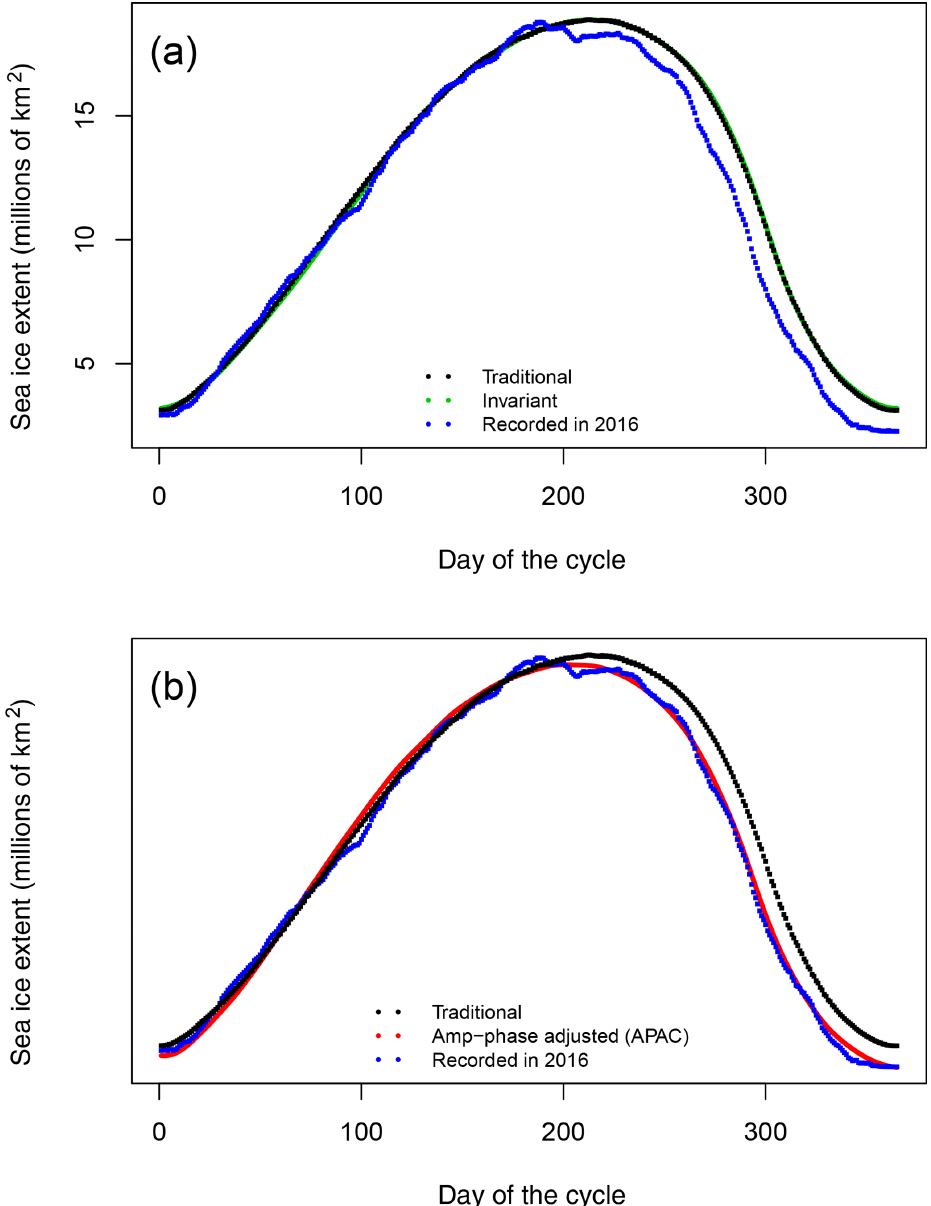
Figure 2. Comparison of annual cycle estimates: (a) a traditional and invariant cycle and (b) a traditional and amplitude- and phase-adjusted cycle. The horizontal axis is the day of the cycle and the vertical axis is sea ice extent in millions of square